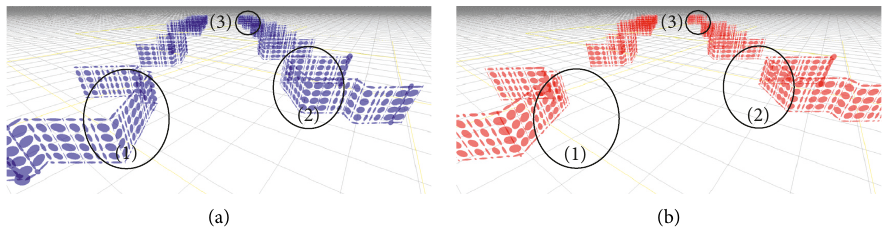
Figure 14: GND maps (a) before environment changes and (b) after environment changes. The circles (1)–(3) indicate the differences between two